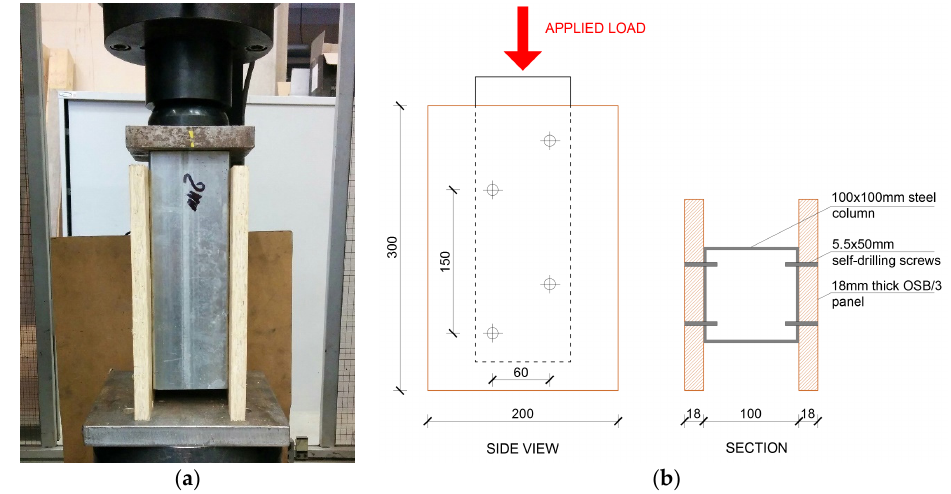
Figure 2. Preliminary laboratory tests: ( a ) photo of a specimen before the test; ( b ) Geometry of the specimens.